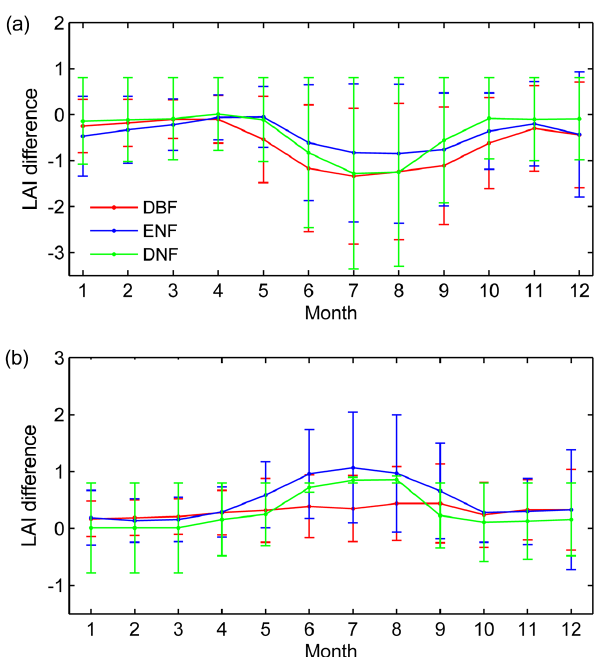
Figure 12. Monthly mean differences between (a) the GLOB- CARBON LAI and the GLOBMAP LAI T (sum of the overstory and understory LAI) and (b) the GLOBCARBON LAI and the GLOBMAP LAI o over the global forest area in the Northern Hemi- sphere based on data from 2008 to